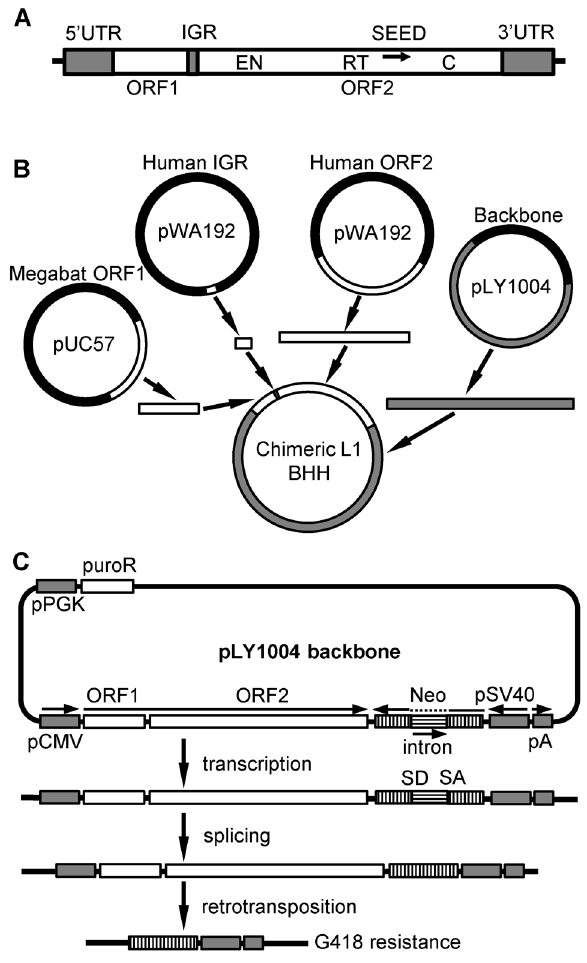
Figure 4. Retrotransposition rate of chimeric L1s. (A) Represen- tative retrotransposition assay plates. Constructs are named with a three letter code based on the origin of their ORF1, IGR and ORF2: H for human L1rp; B for megabat lineage 1. An independent human L1 construct, pWA192 [67], was used as a positive control and an ORF1 mutant of L1rp [68] that blocks retrotransposition was used as a negative control. The number of cells seeded for G418 selection follows the name; 10-fold more cells were used for the negative control and for constructs with low retrotransposition rates. (B) Comparison of retrotransposition rates (log scale). At least 12 plates were counted for each construct in three independent replicate assays.